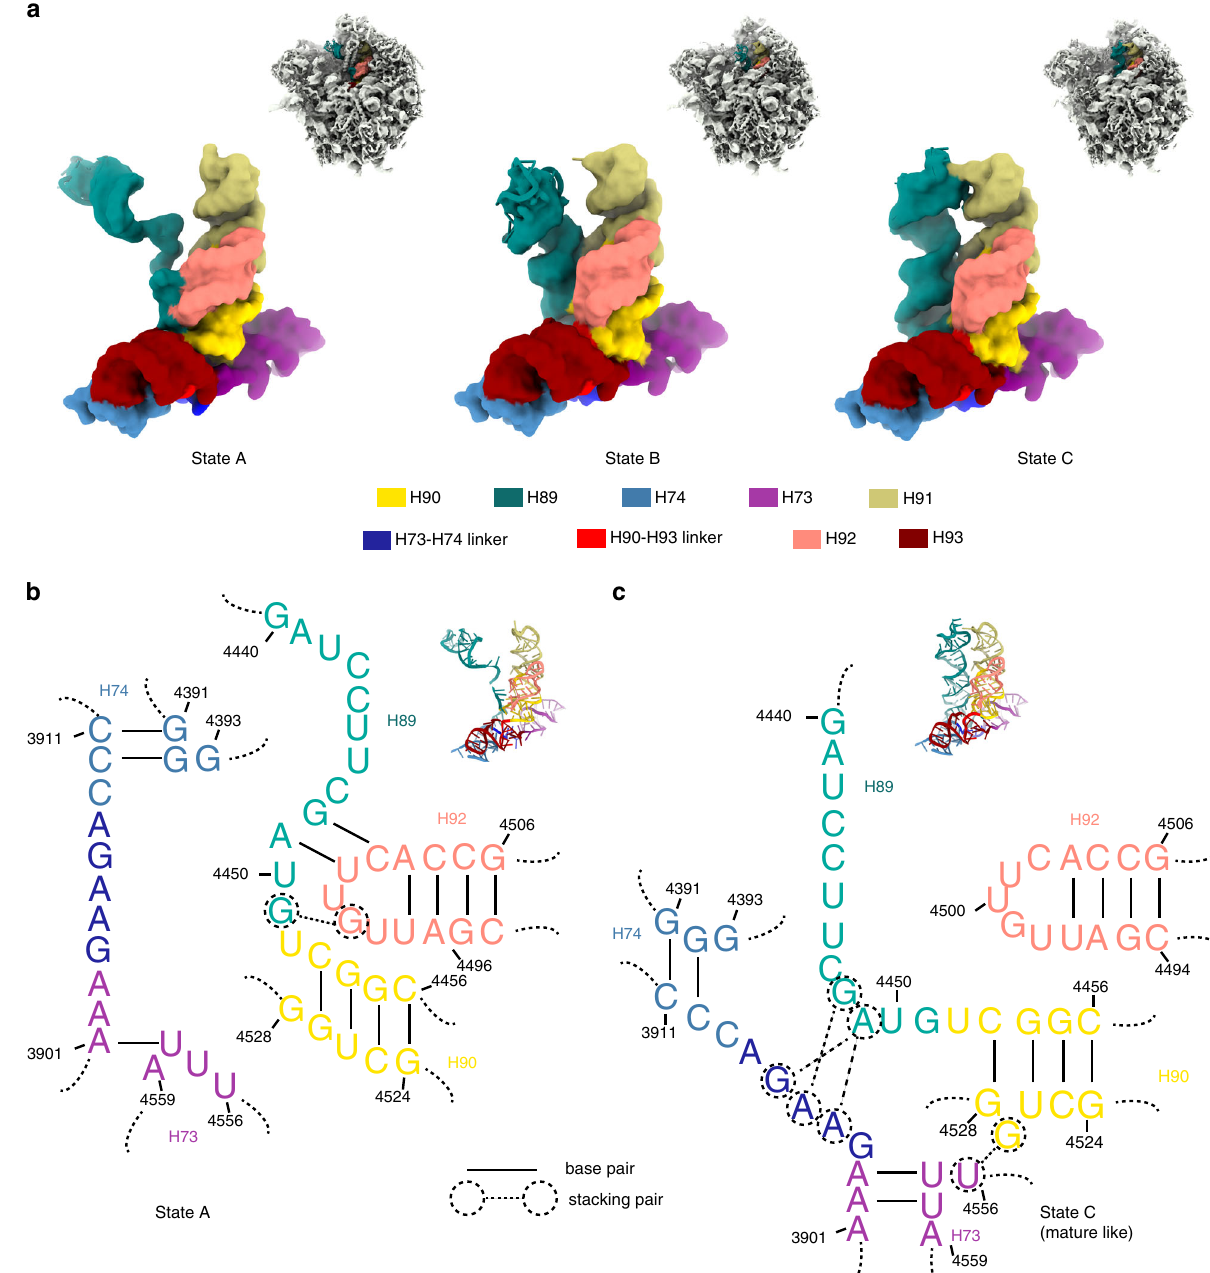
Fig. 6 Coordination between the PTC maturation and tunnel construction. a Overviews of pre-60S density maps (state A, B and C) shown in surface representation, with components of the PTC-PET individually colored. Zoom-in views on the PTC-PET components (H89 to H93, H90-H93 linker and H73- H74 liker) are shown in lower panels. b , c Diagrams of secondary structures of the PTC-PET components in the immature state A ( b ) and mature-like state B/C ( c ), highlighting the contrasting base-pair and base-stacking interactions between the two states. Base-pairings are indicated by black lines and stacking interactions by dashed lines and